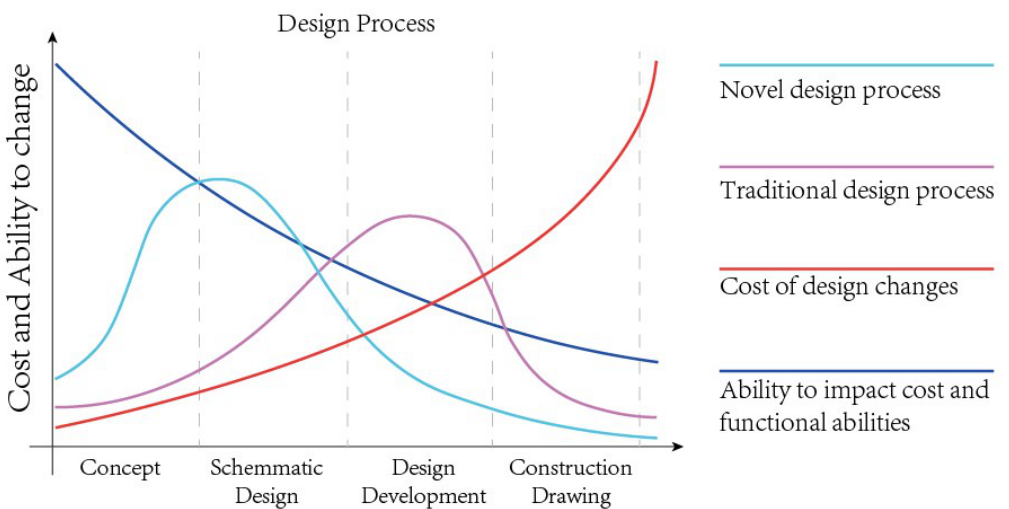
Figure 1. Cost–benefit relationship between traditional and digital architectural design methods in terms of time investment–outcome efficiency.